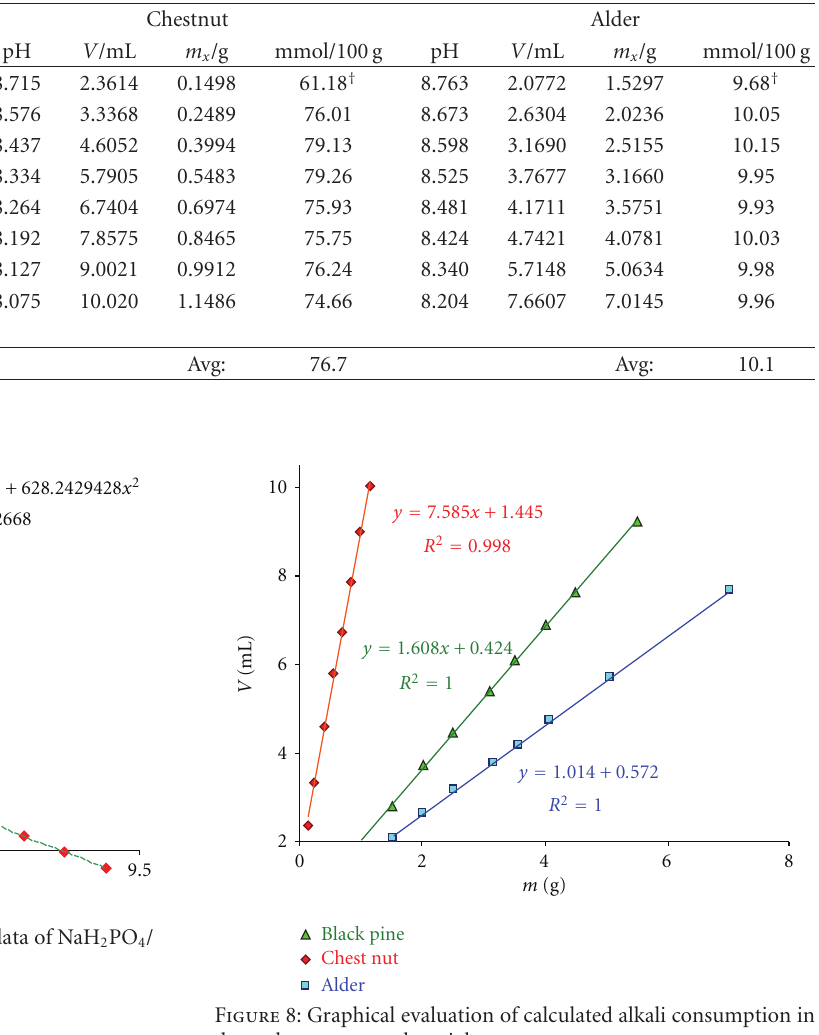
Table 4: Estimation of wood acidity as a function of pH-value of wood-phosphate solutions.